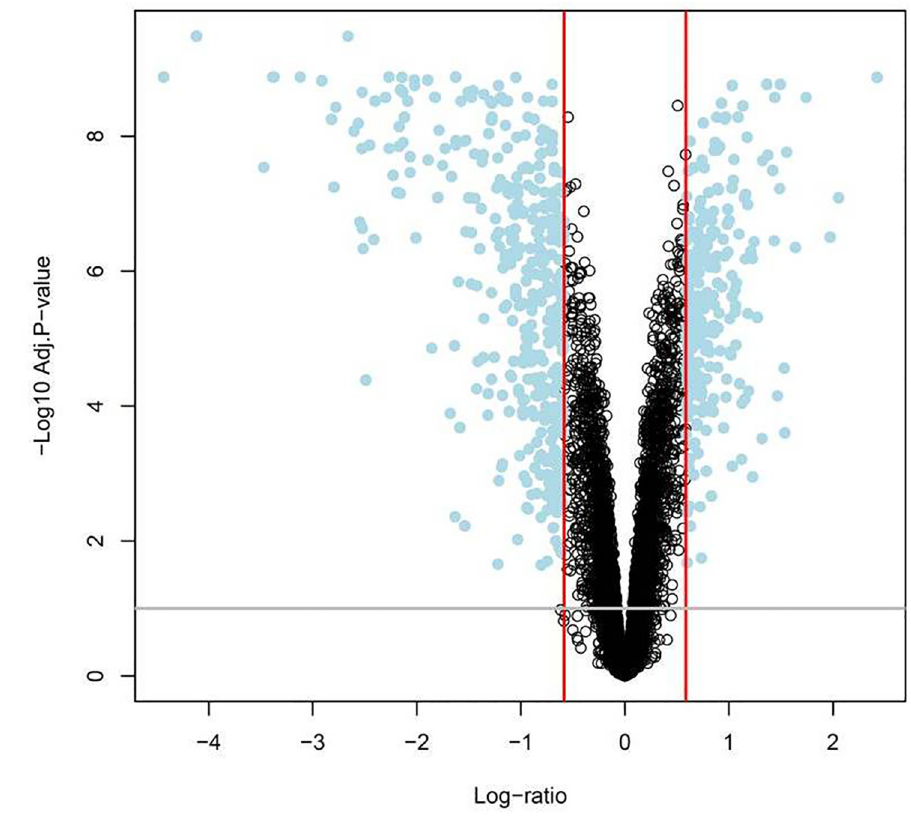
Fig 1. Pregnant women differential expression of visceral versus subcutaneous adipose tissue transcripts. A “ volcano plot ” shows the differential expression of all the transcripts tested in this comparison, with the log (base 10) of the FDR-adjusted probability values (q-value) (y-axis) plotted against the log (base 2) fold-changes (x-axis) between the visceral and subcutaneous adipose tissues.